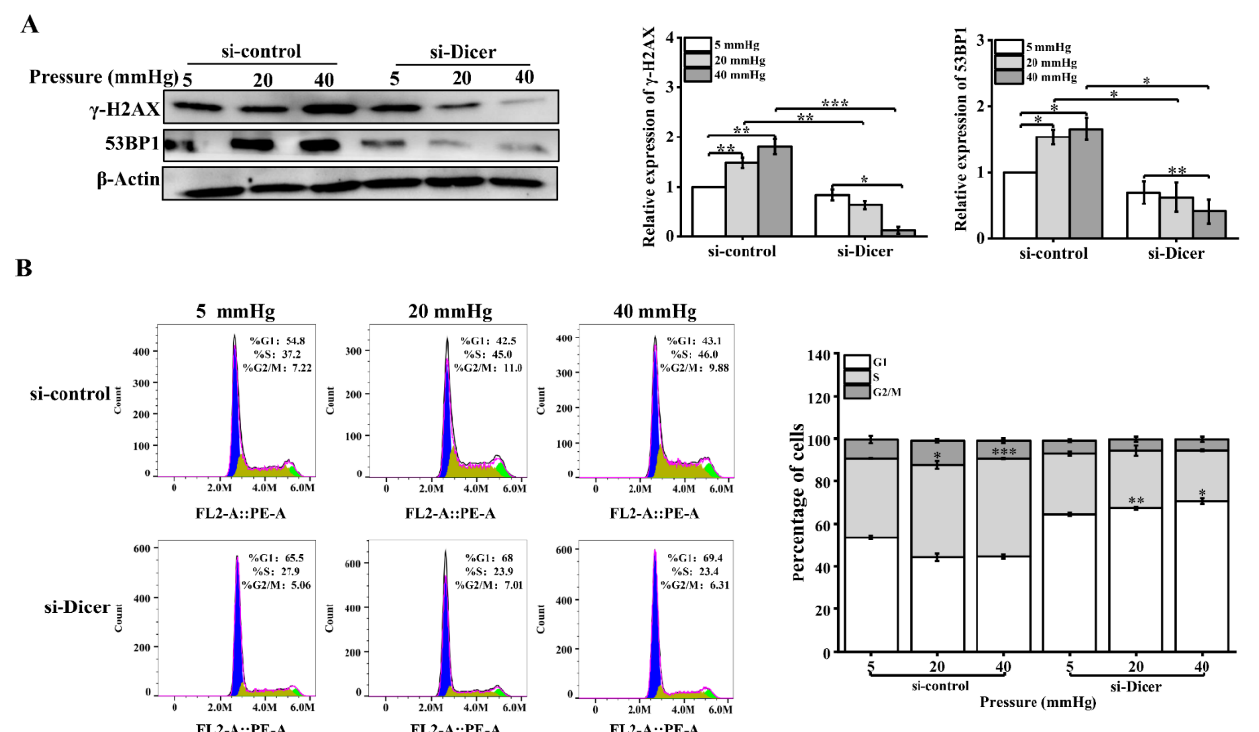
Figure 4. Reduced Dicer expression causes downregulation of DNA repair protein expression and cell-cycle changes in stress-loaded hepatocytes: ( A ) DNA repair proteins in hepatocytes with Dicer knockdown were examined with Western blot and quantification data of the γ -H2AX and 53BP1 protein levels. Cells were exposed to pressure for 48 h; ( B ) cell-cycle distribution was analyzed using flow cytometry following Dicer knockdown and pressure loading for 48 h. The images are representative of three independent experiments. The stacked bar graph indicates the percentage of cells at various stages of the cell cycle. Data are expressed as the mean ± SD. n = 3, * p < 0.05, ** p < 0.01, *** p < 0.001.